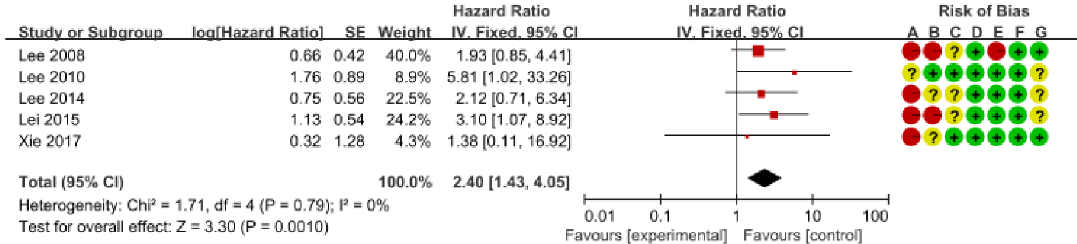
Fig 5. Forest plot of parametrial involvement (-/+) and overall survival of small cell carcinoma of the cervix patients. SE: standard error; CI: confidence interval.